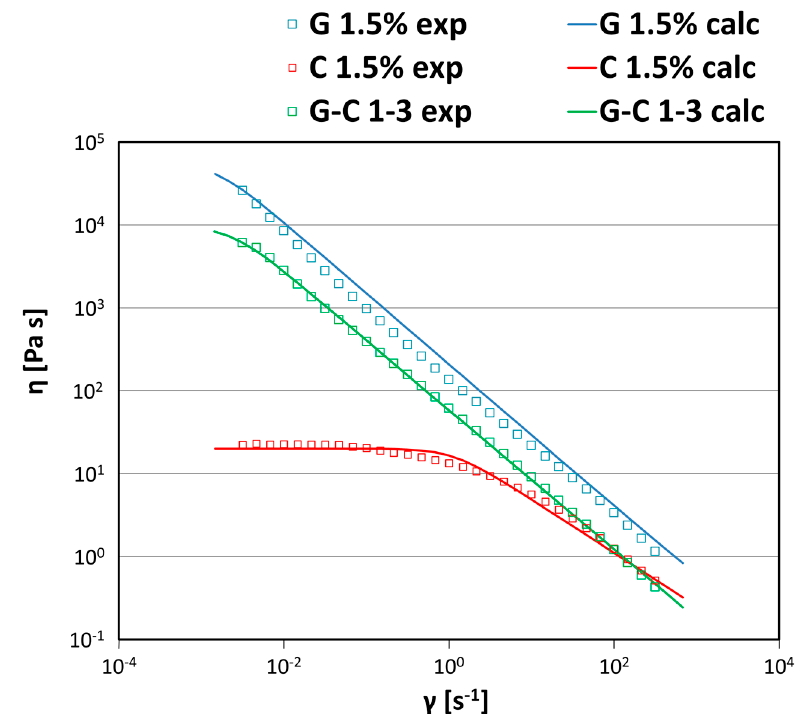
Figure 1. Viscosity curves as a function of the shear rate for the samples prepared with G, C, and the G–C association (1:3) at the same total polymer amount (1.5% w/w ). Flow curves (exp) were fitted with the Carreau − Yasuda model (calc).